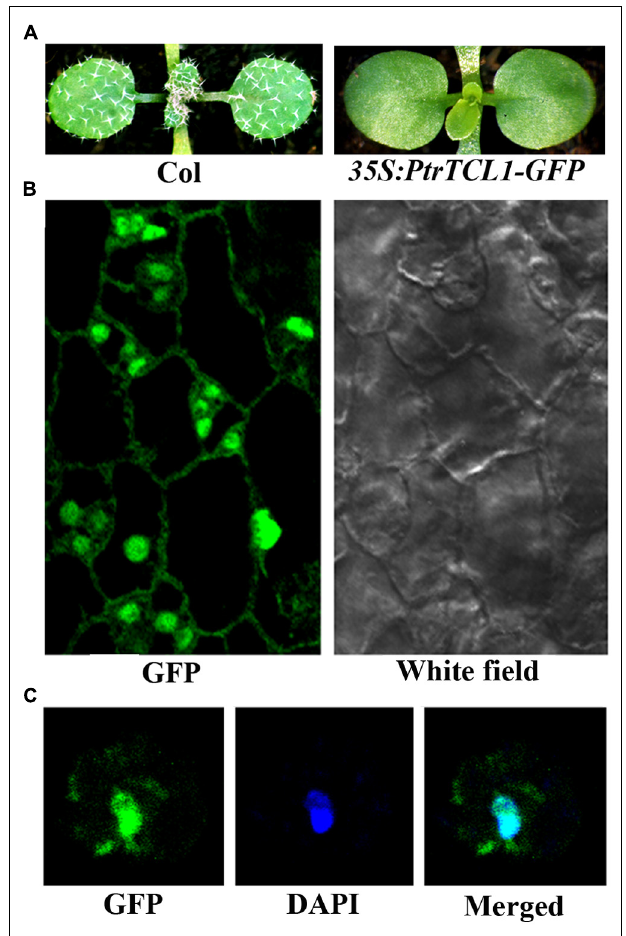
FIGURE 5 | Subcellular localization of PtrTCL1. (A) Expression of PtrTCL1-GFP under the control of 35S promoter in Arabidopsis resulted in a glabrous phenotype. Pictures were taken from 2-week-old, soil-grown seedlings. (B) GFP fluorescence in the epidermal cells of the rosettle leaves in a 2-week-old transgenic plant expressing PtrTCL1-GFP under the control of the 35S promoter. Left panel: GFP channel, right panel: white field image. (C) GFP fluorescence in a protoplast cell isolated from transgenic plant expressing PtrTCL1-GFP under the control of the 35S promoter. Left panel: GFP channel; Middle panel: DAPI channel; right panel: merged.